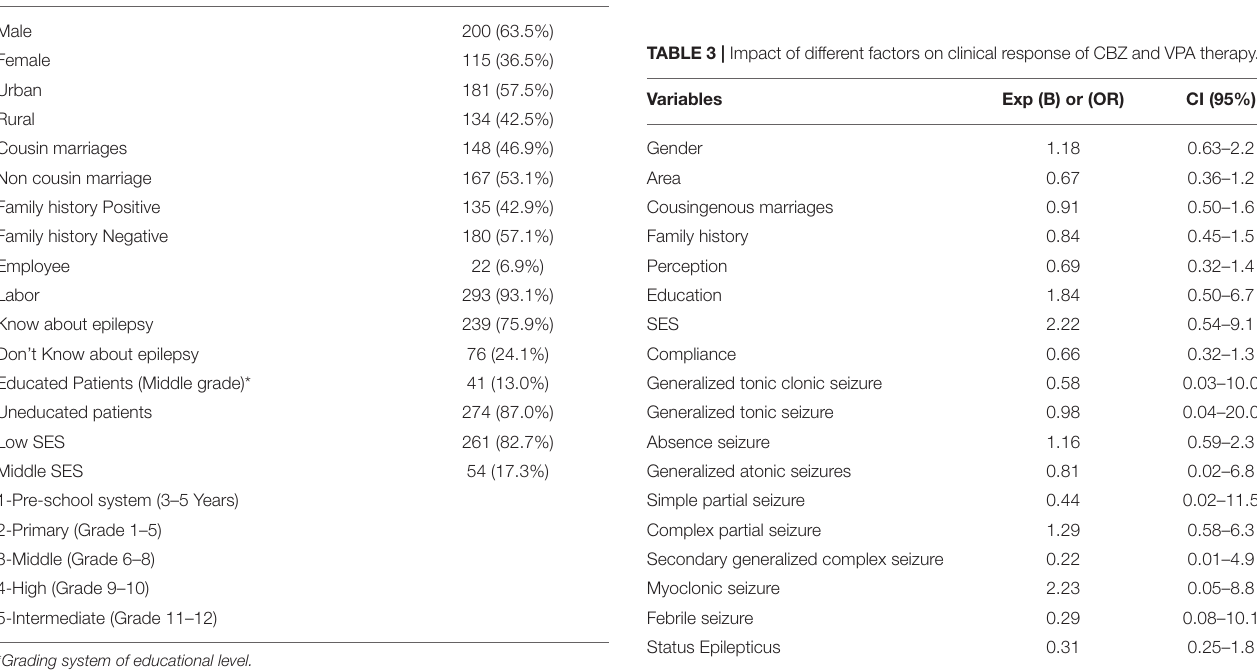
FIGURE 2 | Types of seizures in Pakhtun population.